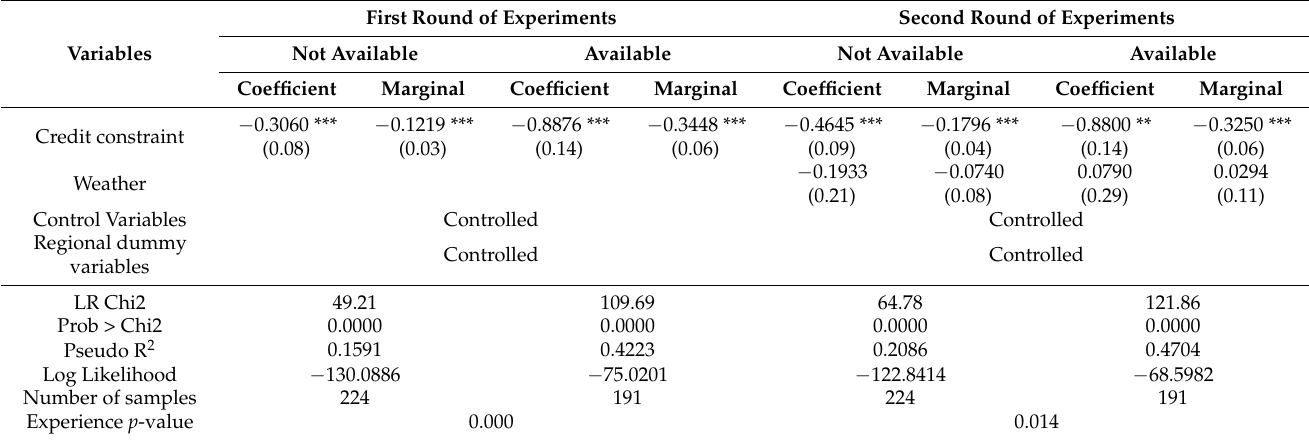
Table 8. Moderating effects of interrelated insurance and credit